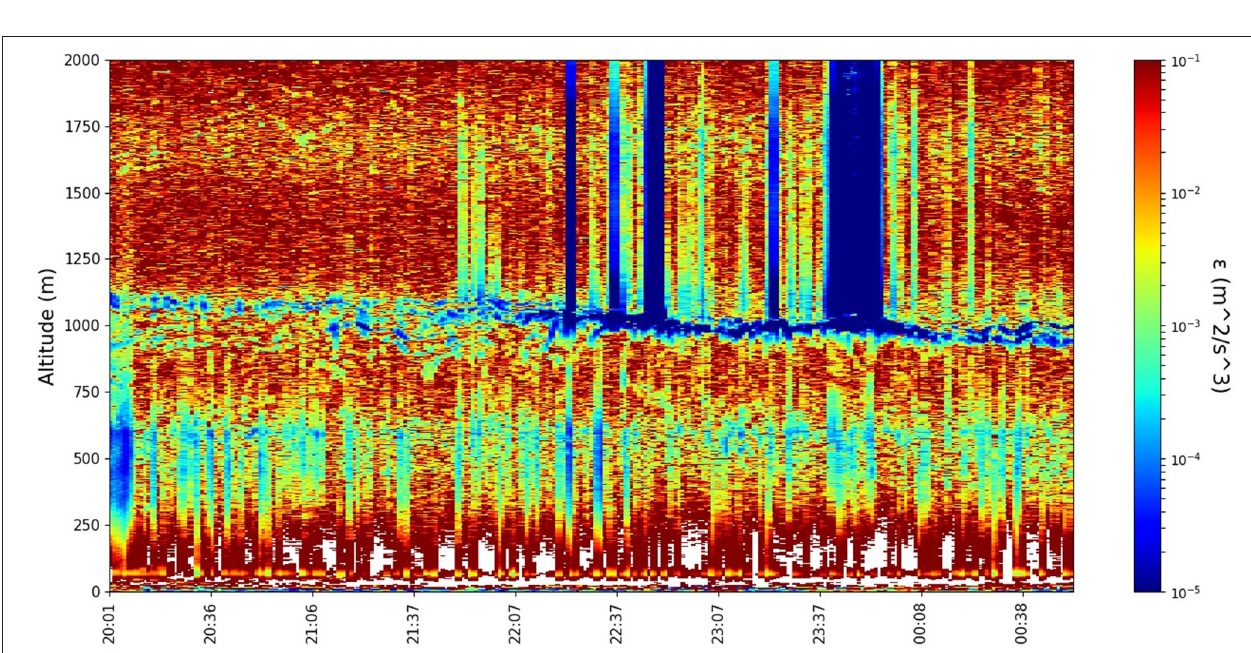
FIGURE 7 | ε ( z ) timeseries on the 28th of May 2017 calculated with multifractal theory and lidar-obtained length scales; temporal resolution: 3min; spatial resolution: 3.75m.